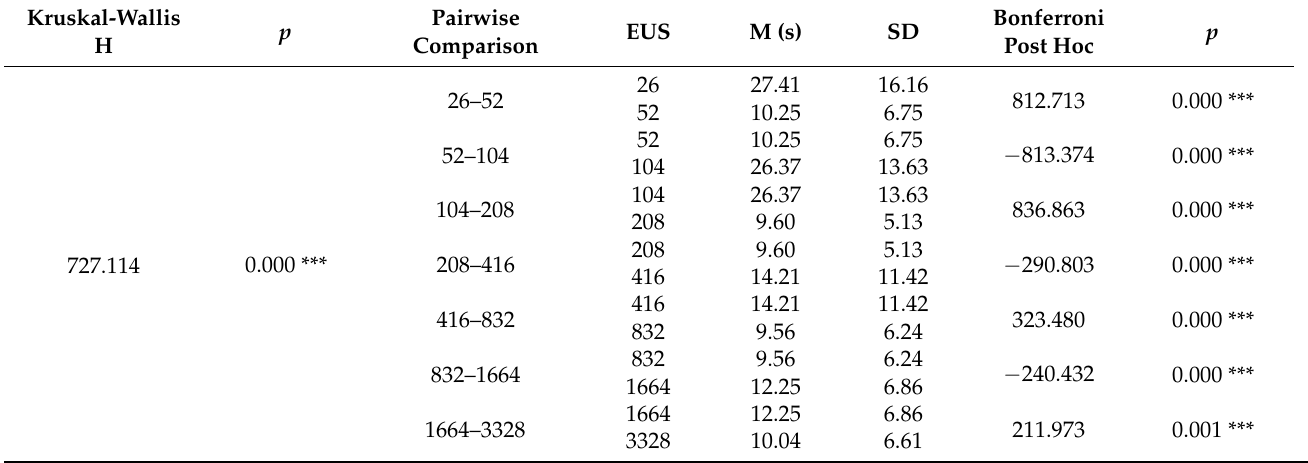
Table 7. Task 7 and the pairwise comparison of the answer times, *** p ≤